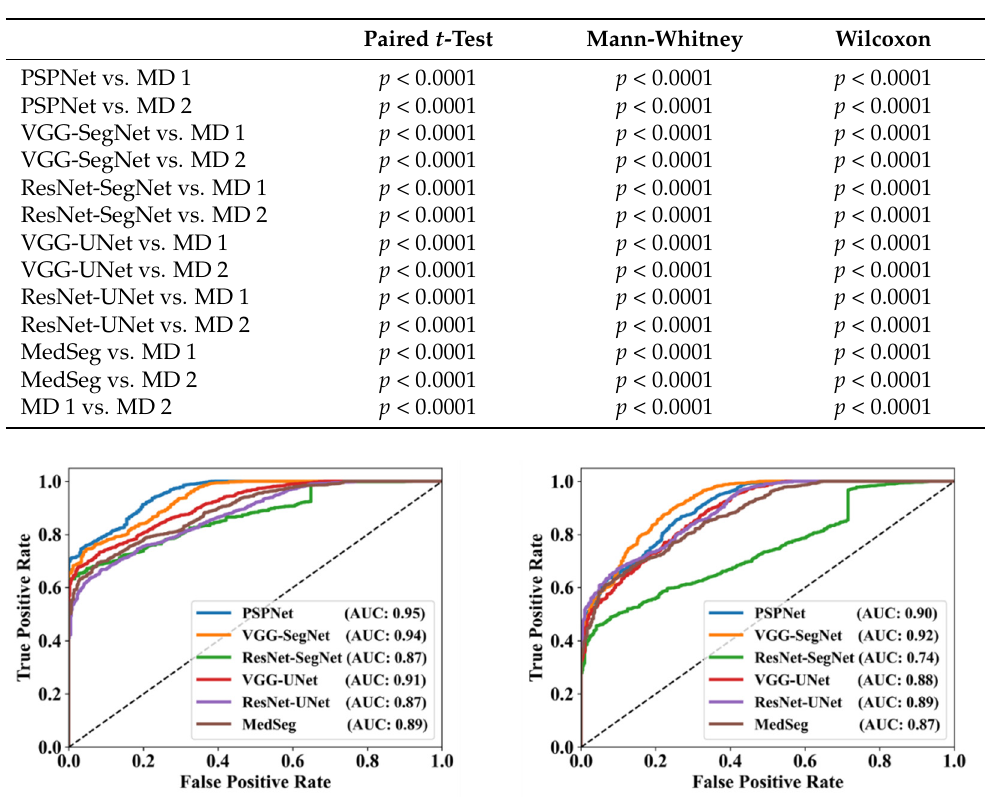
Table 3. Statistical tests for the 5 AI models and MedSeg against MD 1 and MD 2.